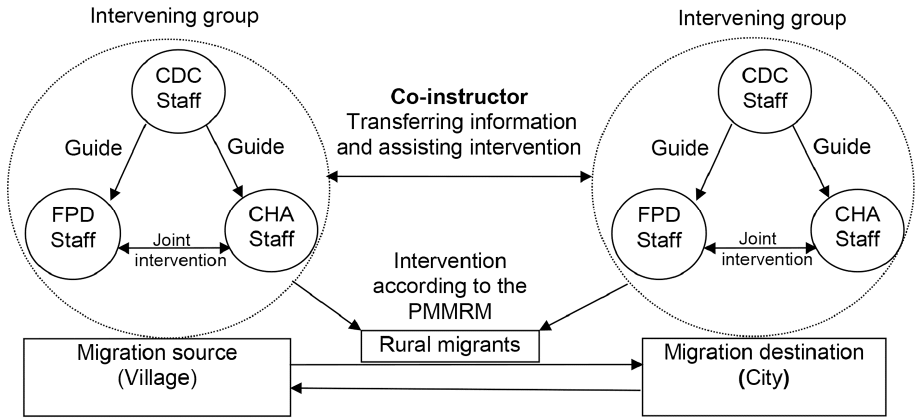
Figure 2. Framework of